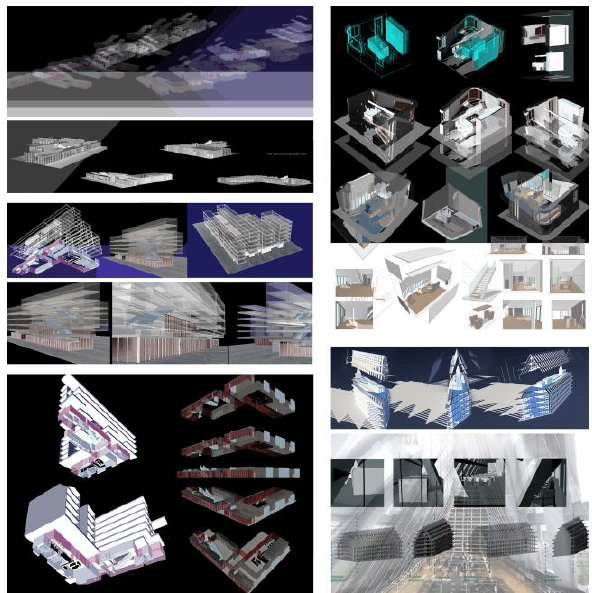
Figure 6. New Bocconi University headquarters in Milan - Grafton building (2008); Giangiacomo Feltrinelli Foundation, Milan, Herzog & de Meuron; Penthouse one-11, Milan (Hadid Architects). IMD: Continuous and uninterrupted